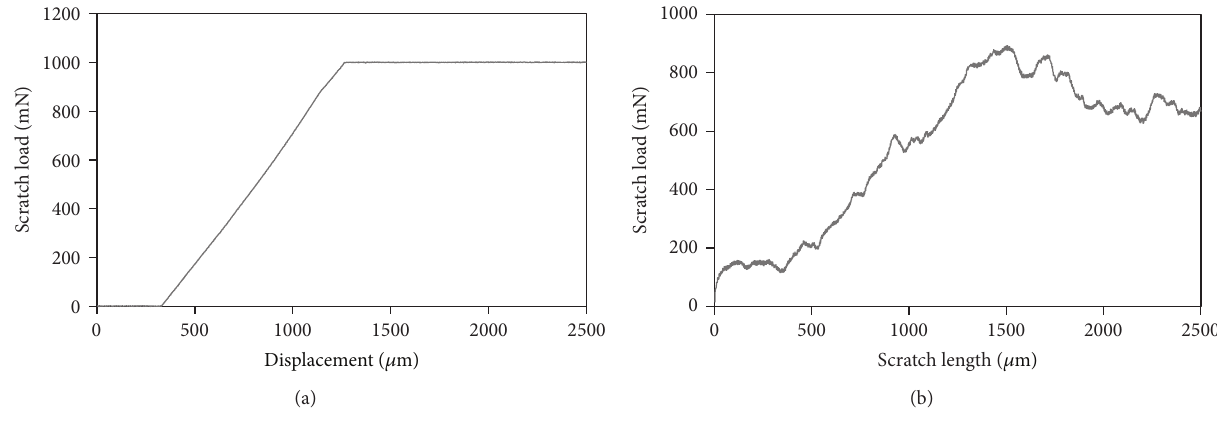
Figure 5: (a) Microscratch loading profile; (b) typical microscratch